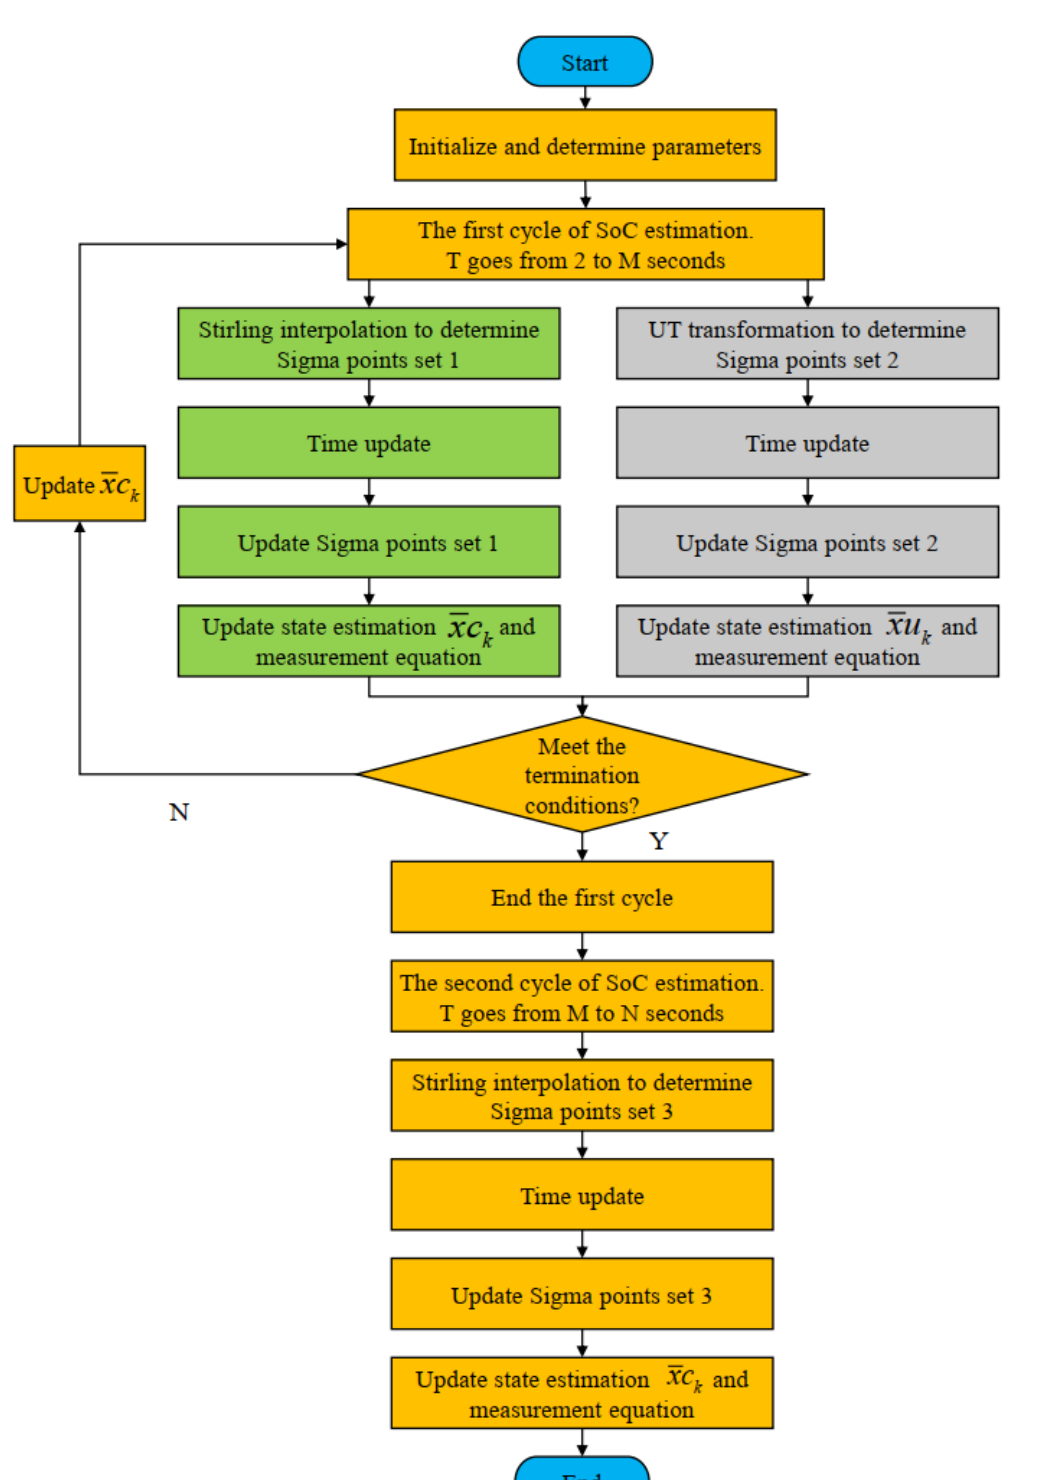
Figure 5. Flow chart of the proposed algorithm.